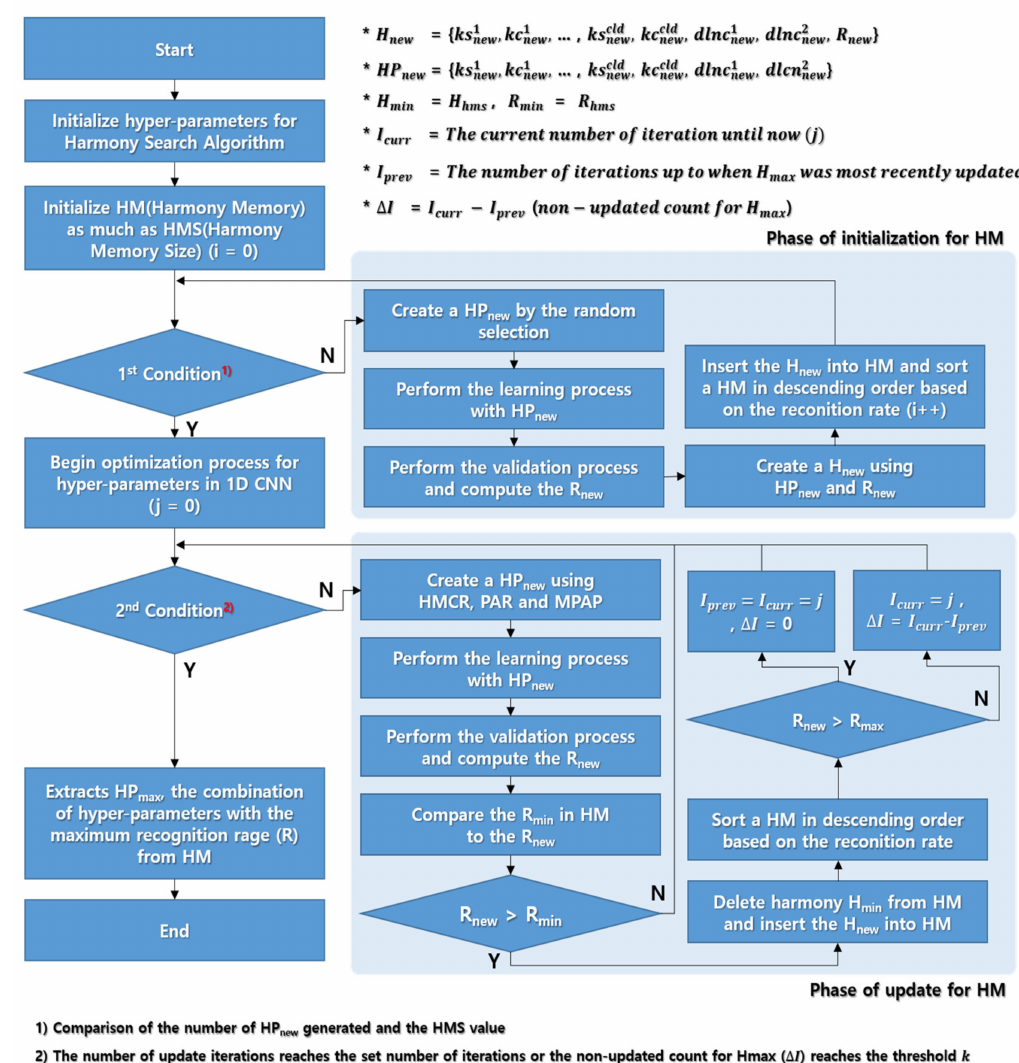
Figure 6. 1D CNN hyperparameter optimization process using HS